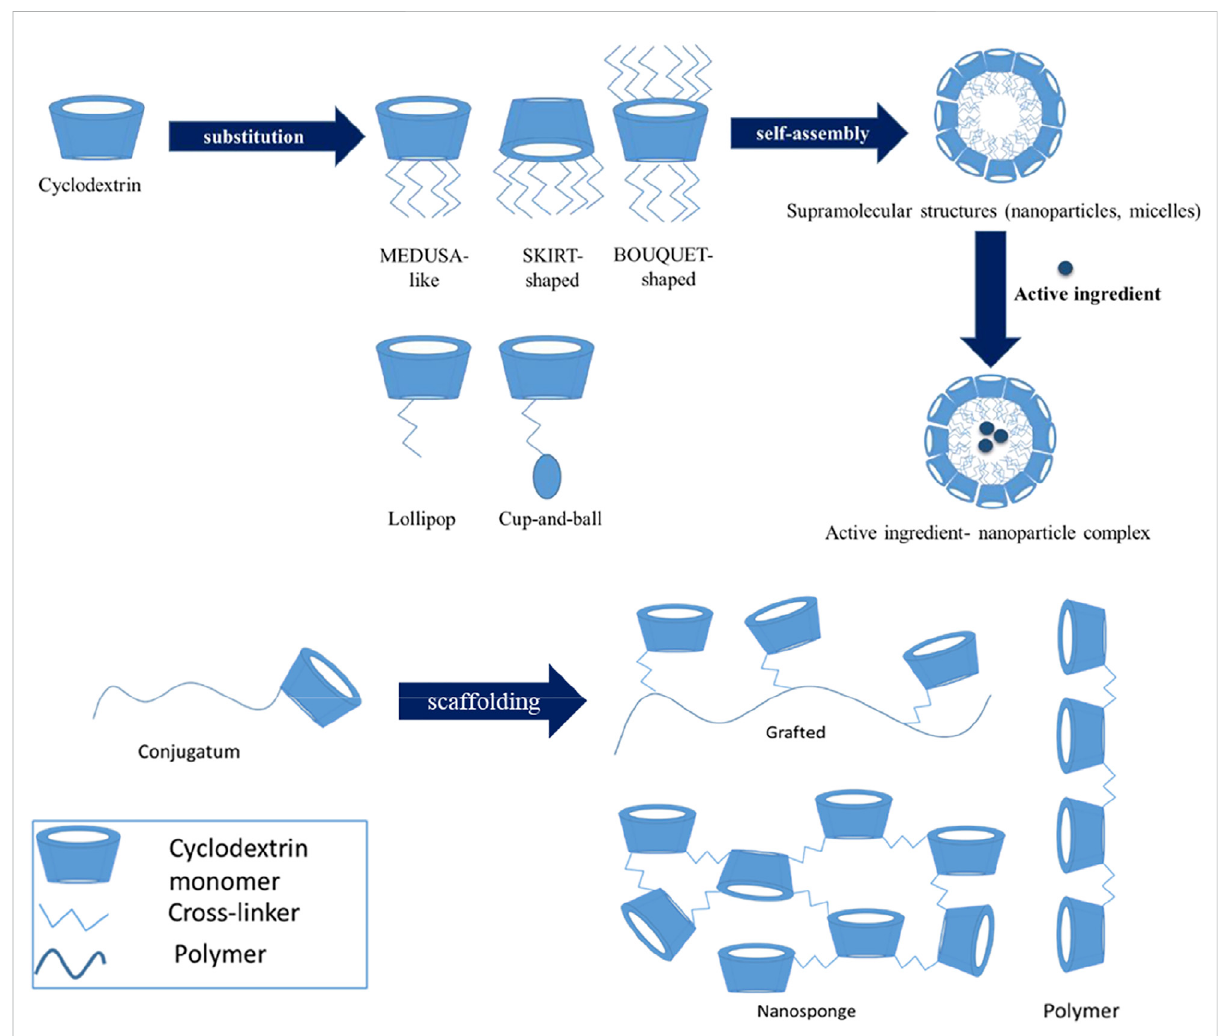
FIGURE 1 Architectures of CD and CD-based polymers for drug delivery. Haimhoffer et al. (2019).